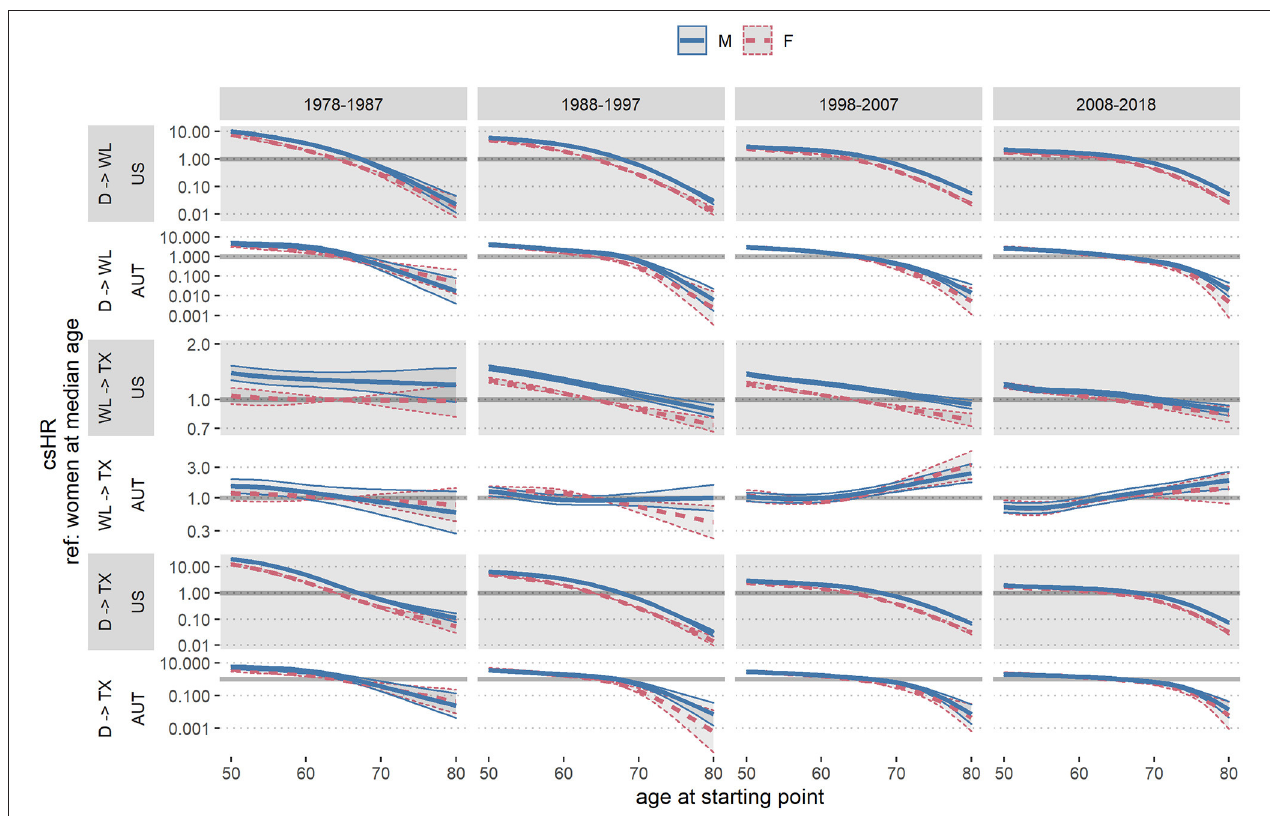
FIGURE 3 | Austrian (AUT) and US cause specific hazard ratios (csHRs) and 95% confidence intervals by sex and age at the respective starting state, with median aged females as reference group, per country and decade. (D) dialysis initiation, (WL) first entry in wait-list, (TX) first kidney transplantation. Age is incorporated via restricted cubic splines. Results are based on data from the ADTR/Eurotransplant (AUT) ( 26, 29) and USRDS (USA)